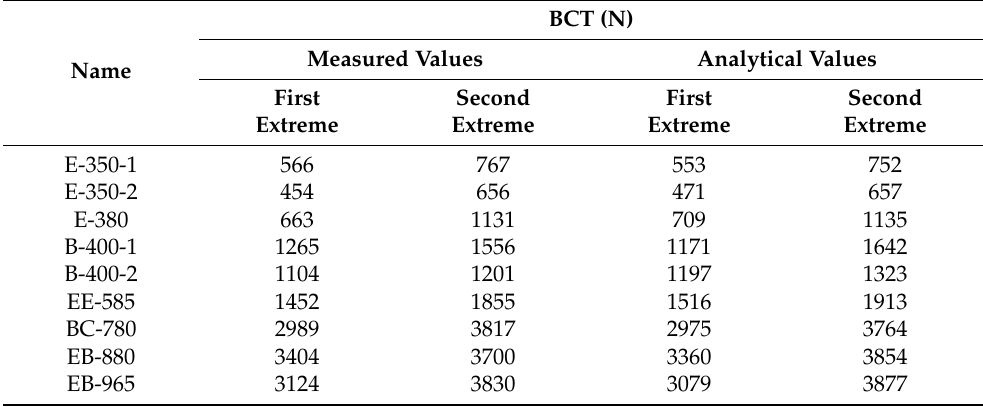
Figure 13. The prediction error distribution obtained while using the analytical model: ( a ) first extreme; ( b ) second extreme. Table 6. Comparison of measured and analytically determined BCT values for various corrugated cardboard